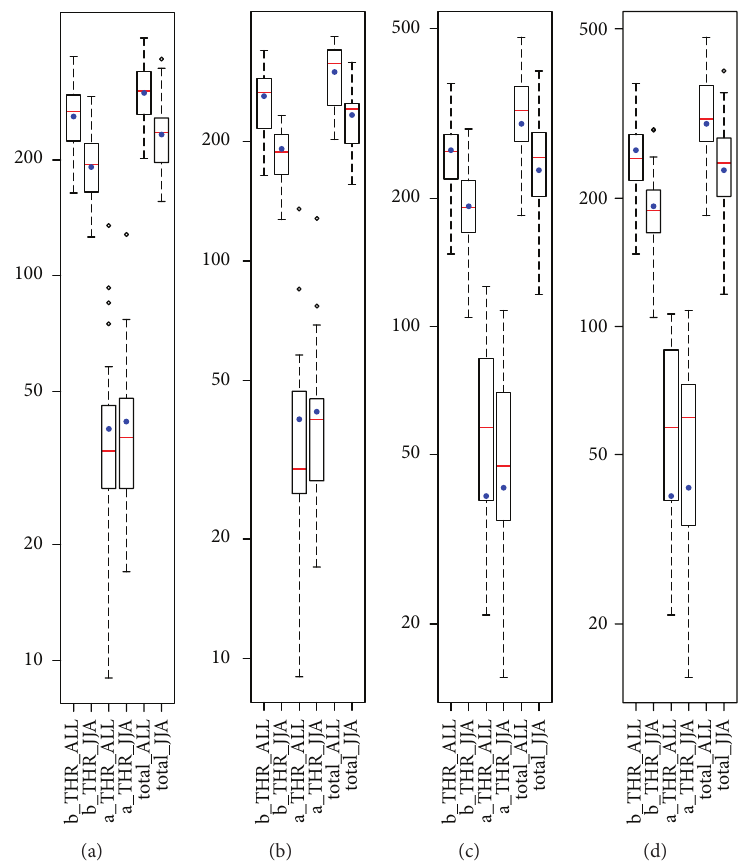
Figure 2: Boxplots for annual precipitation amounts averaged for one station: b THR ALL: events below THR for ALL, b THR JJA: events below THR for JJA, a THR ALL: events above THR for ALL, total ALL: total amount for ALL, and total JJA: total for JJA; (a) western 1966–2006, (b) western 1982–2006, (c) eastern 1966–2006, and (d) eastern 1982–2006.